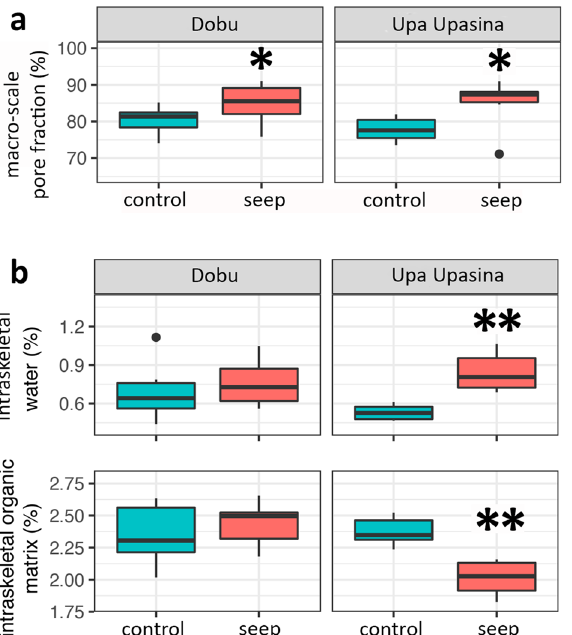
Figure 3. Macro-scale pore volume fraction (in the figure simply macro pore fraction) and intraskeletal OM and water content for P. damicornis from control and seep sites at Dobu and Upa Upasina. ( a ) Time Domain- Nuclear Magnetic Resonance measurement of macro-scale pore volume fraction. ( b ) Thermogravimetric Analysis of microscale parameters, namely intraskeletal organic matrix (OM), intraskeletal water content, and total (the sum of OM and water). The box indicates the 25th and 75th percentiles and the line within the box marks the median. Whisker length is equal to 1.5 × interquartile range (IQR). Circles represent outliers. Significant differences between control and seep sites are represented by asterisks, ** P < 0.01, * P < 0.05. Plots were created with the R package ggplot2 62 .